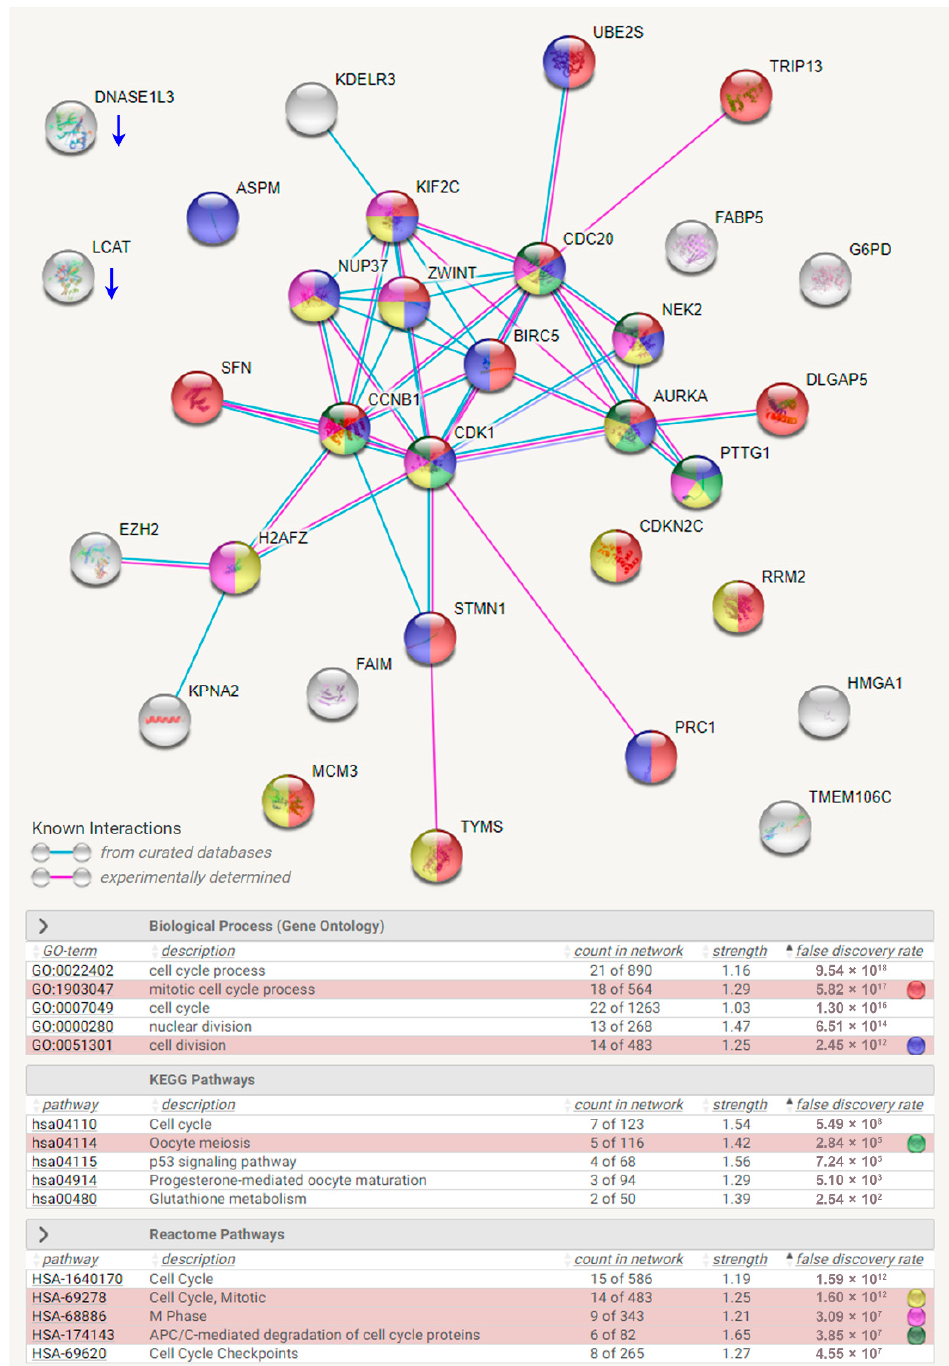
Figure 2. Pathway enrichment for the prognostic gene signature in hepatocellular carcinoma. The interaction network construction and pathway enrichment for the common gene signature in HCC was performed using the STRING database. The selected pathways are highlighted in different colors.